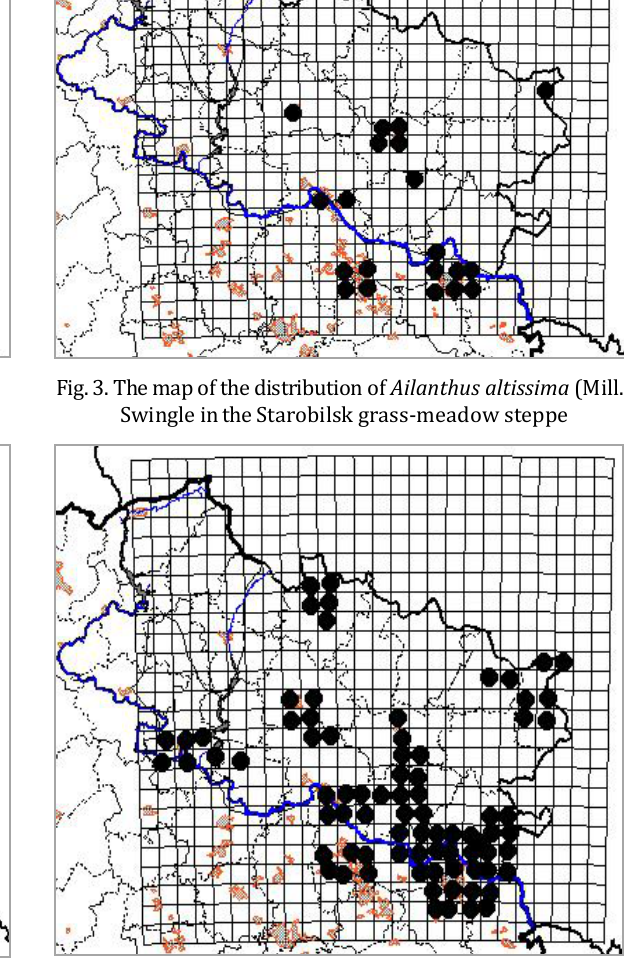
Fig. 5. The map of the distribution of Amaranthus retroflexus L. in the Starobilsk grass-meadow